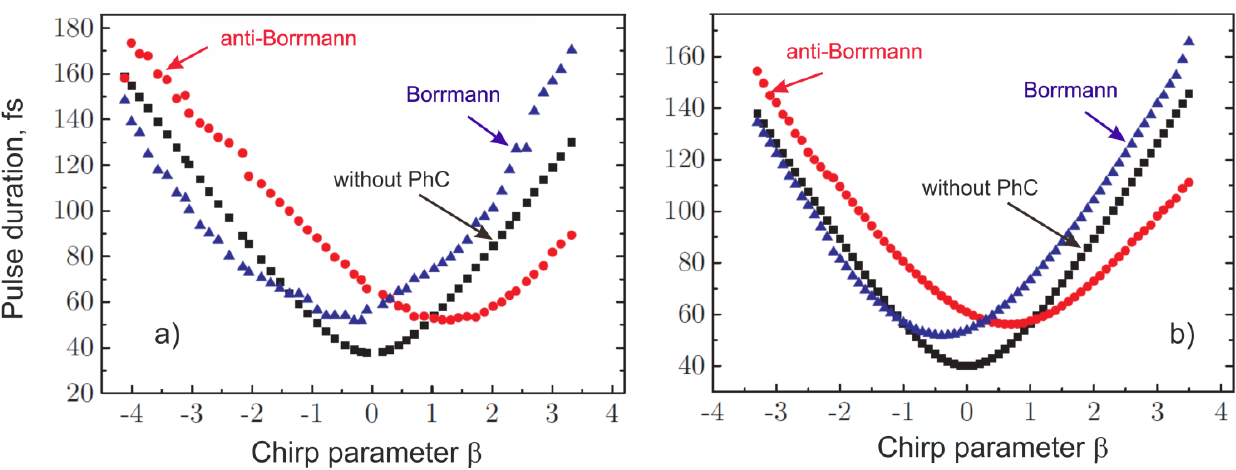
Figure 4. ( a ) Experimental and ( b ) calculated dependencies of the values of the duration of the Borrmann, anti-Borrmann and input chirped pulses on the chirp parameter